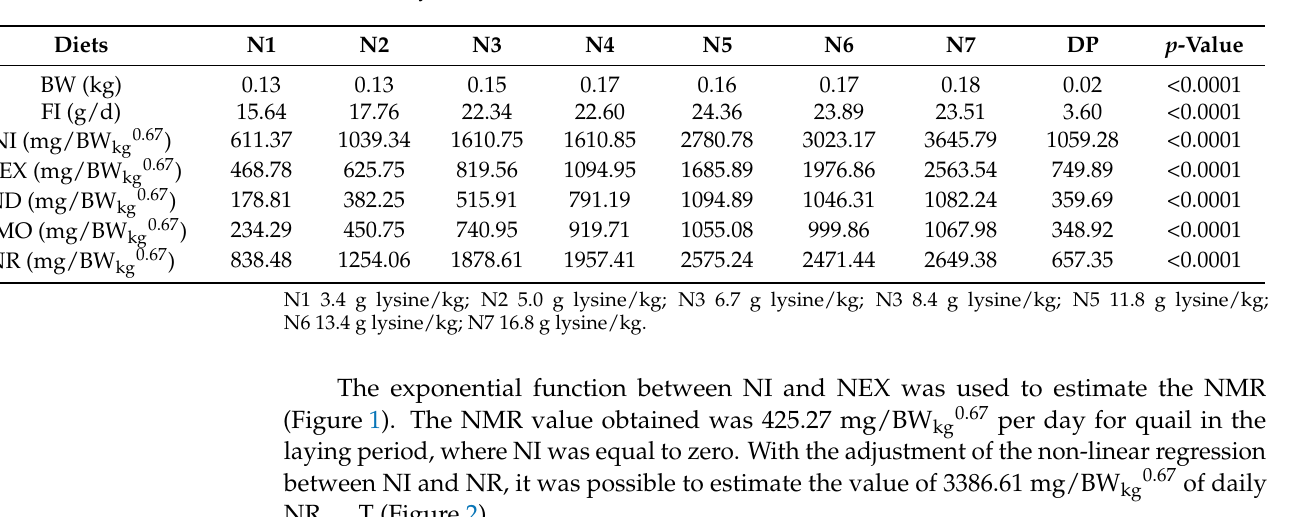
Table 6. Mean body weight (BW, kg), feed intake (FI, g/d), daily nitrogen intake (NI, mg/BW kg0.67